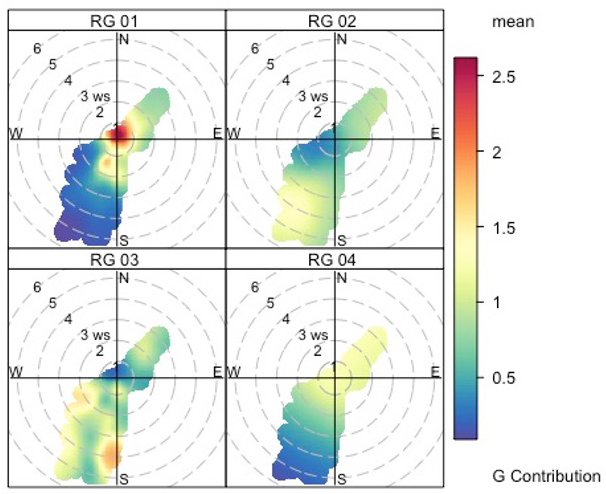
Figure 8. Polar plot of the average G contributions of the factors from the RG